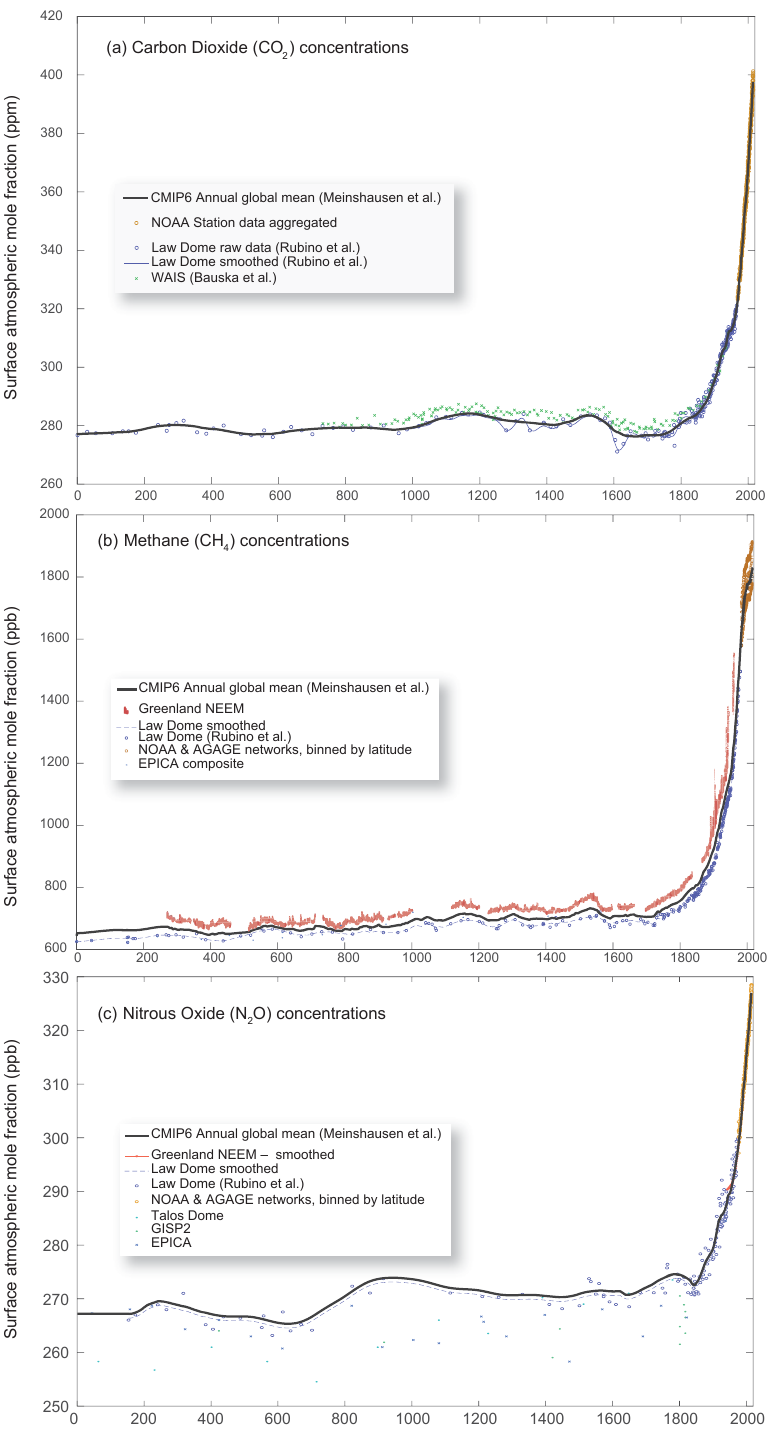
Figure 1. Historical atmospheric surface concentrations from year 1BC to year 2014CE of carbon dioxide, methane, and nitrous oxide. The PMIP recommendation is to use GHG concentrations for past1000 consistently with the historical CMIP6 runs. Here shown are global-mean concentrations of these fields (thick black line), in comparison with key Antarctic ice core and Greenland firn data sets (see the legend). The latitudinal gradient for CO 2 is assumed zero before 1850CE. For methane, NEEM and Law Dome ice core data provide an indication of the latitudinal gradient during pre-industrial times, which is reflected in the extended CMIP6 data set. N 2 O measurements from Antarctic ice cores vary substantially between studies. The extended CMIP6 data set follows a smoothed version of the Law Dome